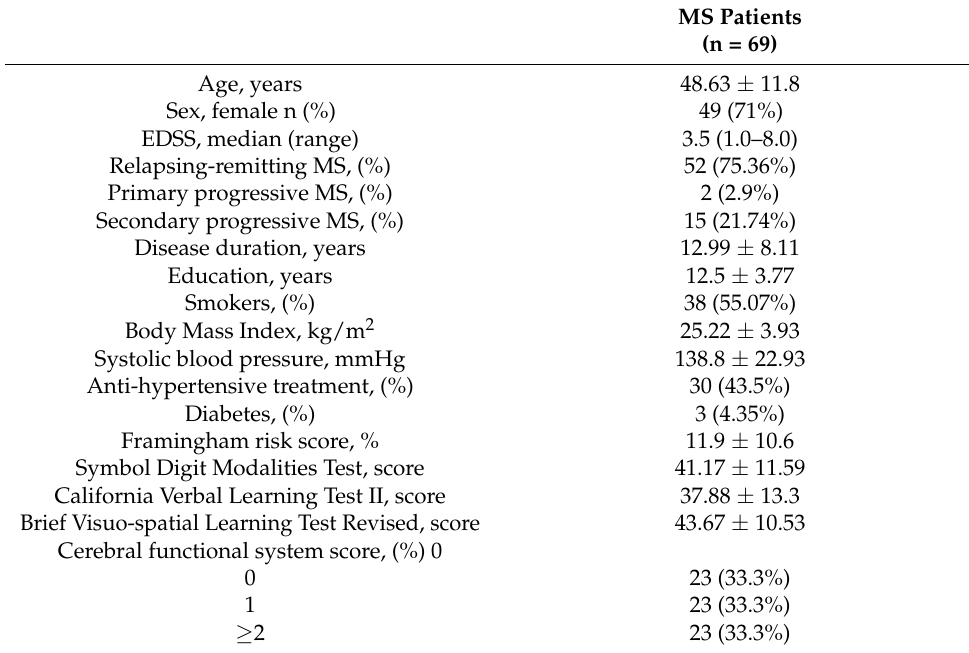
Table 1. Demographic, clinical, cardiovascular, and neuropsychological